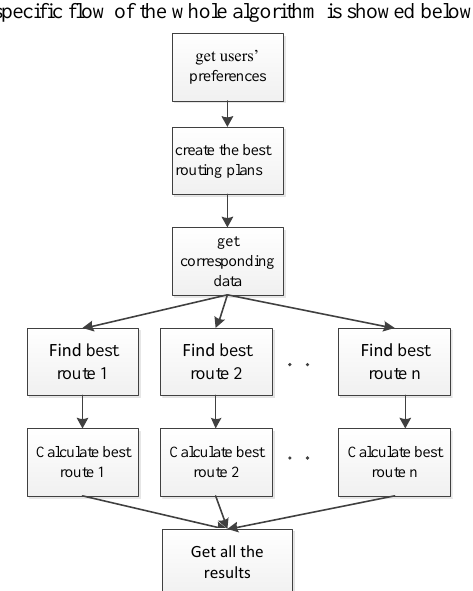
Figure 4. Algorithm Flow Chart of Multimodal Route